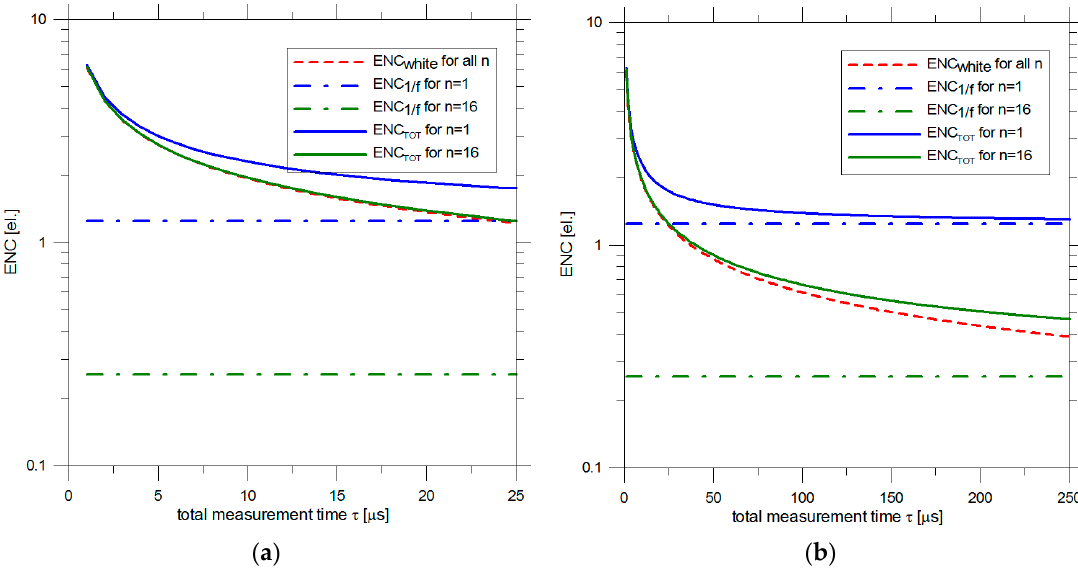
Figure 7. Calculated ENC components of a typical DEPFET processed by a triangular filter as a function of the total measurement time for two different number of readouts n = 1 and n = 16 for ( a ) fast readout and ( b ) slow readout.